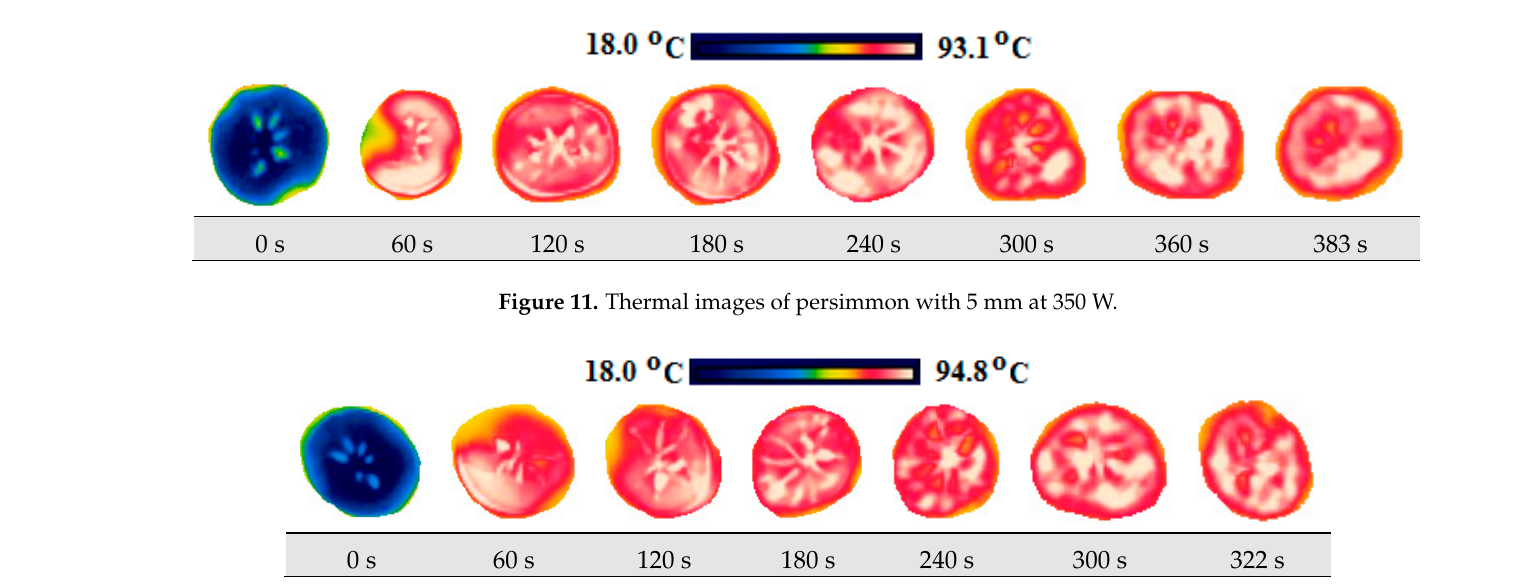
Figure 10. Thermal images of persimmon with 5 mm at 120 W.